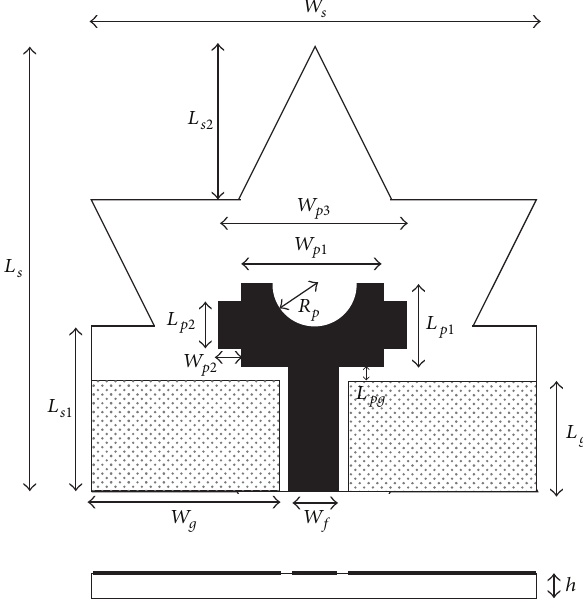
Figure 1: Schematic configuration of the proposed defected sub- strate CPW-fed wideband antenna.